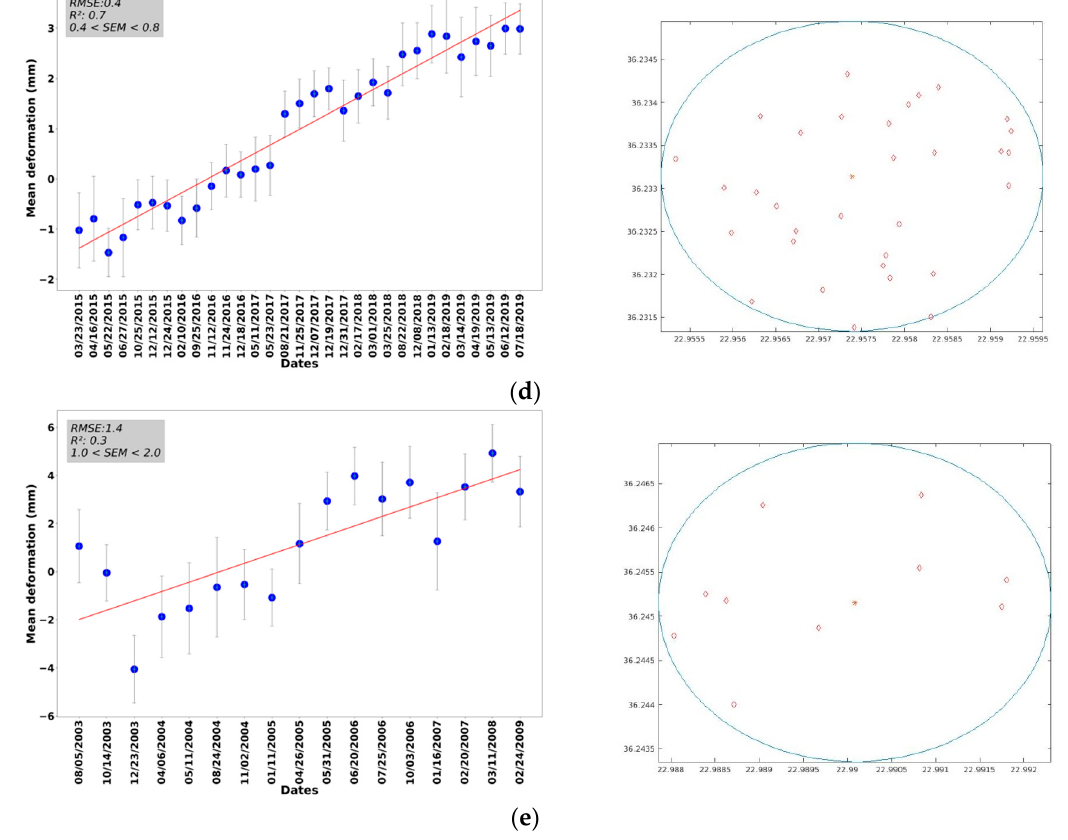
Figure 6. Time-series plots for scatterers included in 200-m radius around two distinctive regions to the West of the Mitata village, characterized by positive LOS displacements. ( a ) The area NW of the Mitata village (Sentinel-1 ascending track no.102); ( b ) The area SW of the Mitata village (Sentinel-1 ascending track no. 102); ( c ) The area NW of the Mitata village (Sentinel-1 descending track no. 7); ( d ) The area SW of the Mitata village (Sentinel-1 descending track no. 7); ( e ) The area to the west of the Mitata village (Envisat ascending track no. 415).